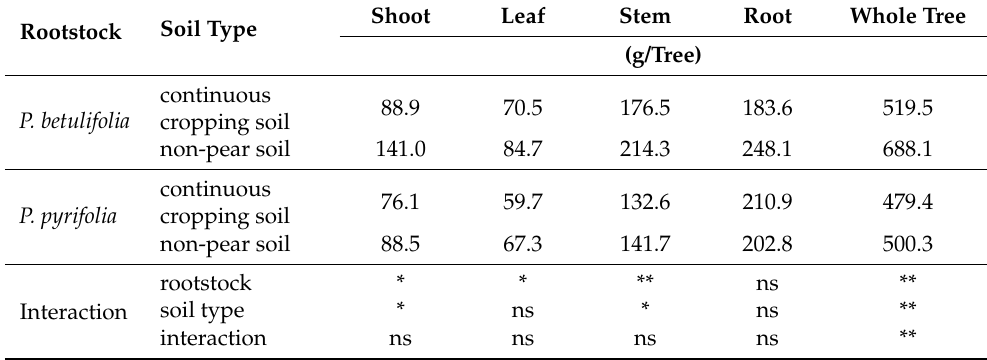
Table 7. Effects of rootstock and soil types on the growth (dry weight) of Japanese pear